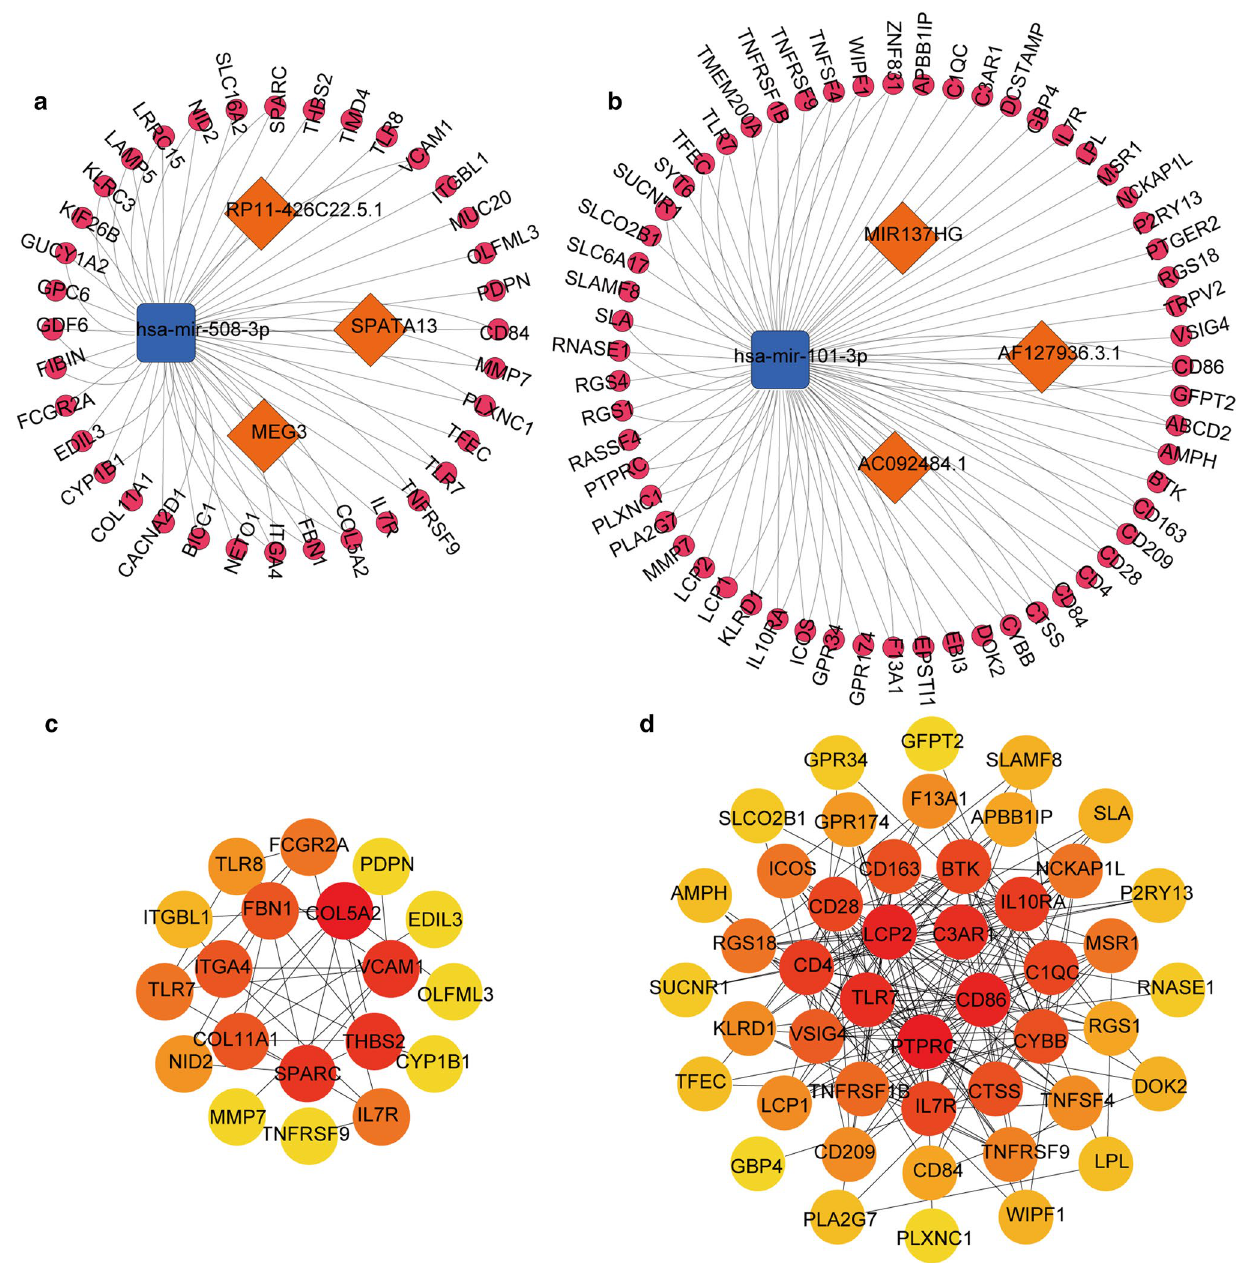
Fig. 5 Construction of ceRNA interaction network and PPI network. a , b CeRNA network based on Stromal/ESTIMATE Score. The orange dia- mond represents the up-regulated lncRNA, the blue rounded rectangle represents the down-regulated miRNA, and the rose red circle rep- resents the up-regulated mRNA. c , d PPI network of key mRNA based on Stromal/ESTIMATE Score constructed by DAVID database. Node represents DEmRNAs (confidence score > 0.4) and the color of each node represents the degree score of each